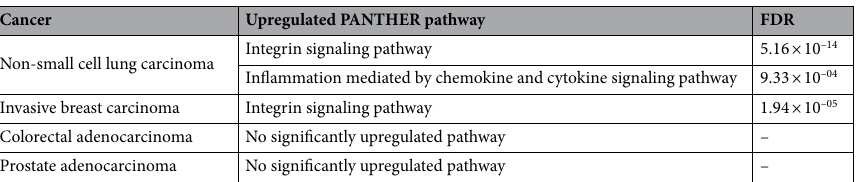
Table 3. Significantly upregulated pathways for DCBLD1 high expression patients in the four TCGA cohorts.